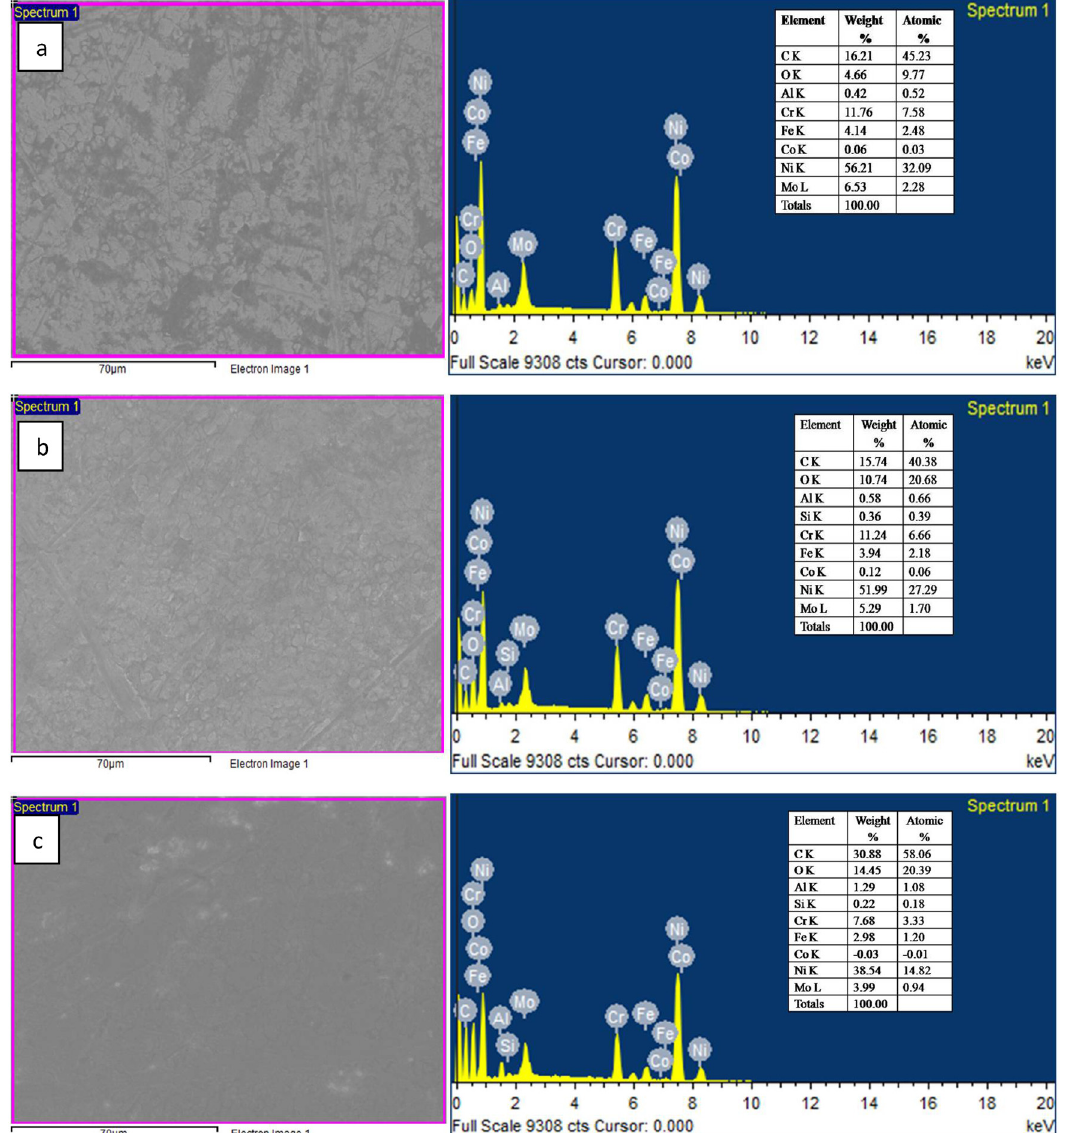
Figure 4: Microstructures and SEM/EDX spectra matrix at fusion zone locations for: ( a ) 80 amp, 250 mm · min − 1 ; ( b ) 92.5 amp, 275 mm · min − 1 and ( c ) 105 amp, 300 mm · min − 1